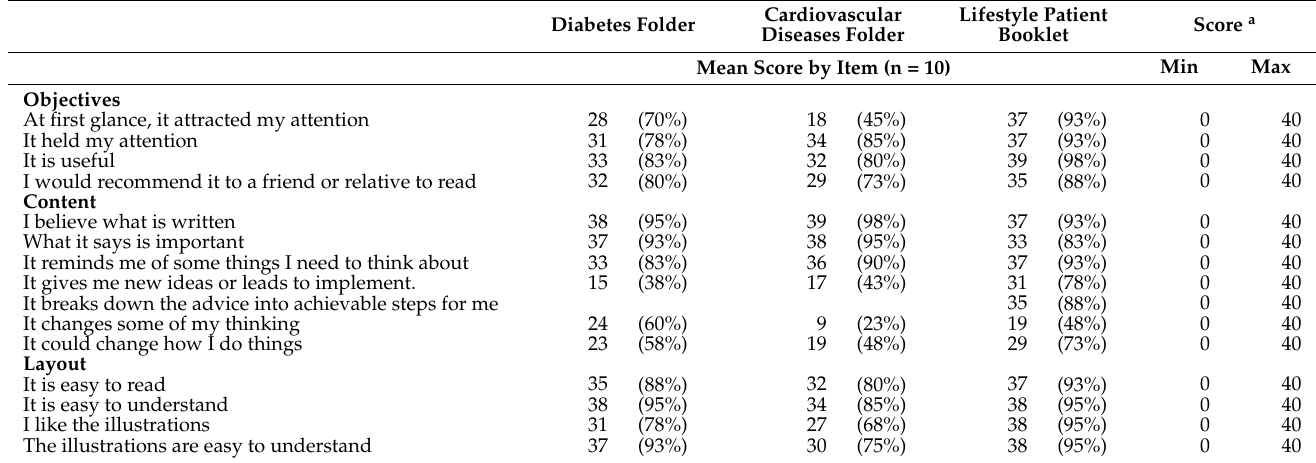
Table A2. Results of the evaluation questionnaire regarding the perceptions on purpose, content, and layout of the patient education